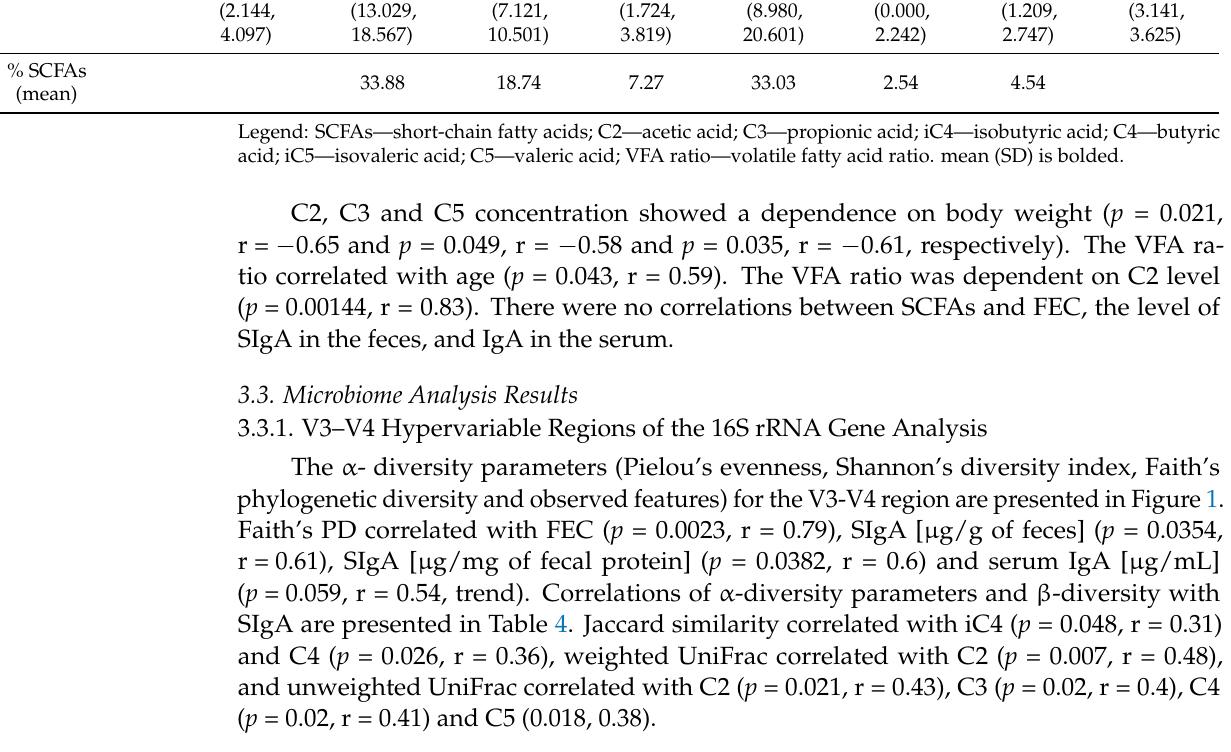
Table 4. Correlations between β -diversity parameters and SigA in feces for analysis of V3–V4